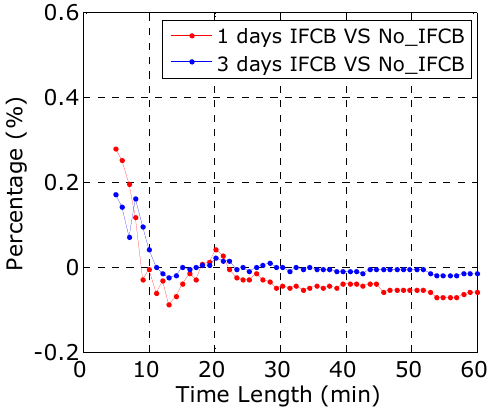
Figure 7. Improvement in fixing percentage for various observation durations using one-day and three-day IFCB estimates.